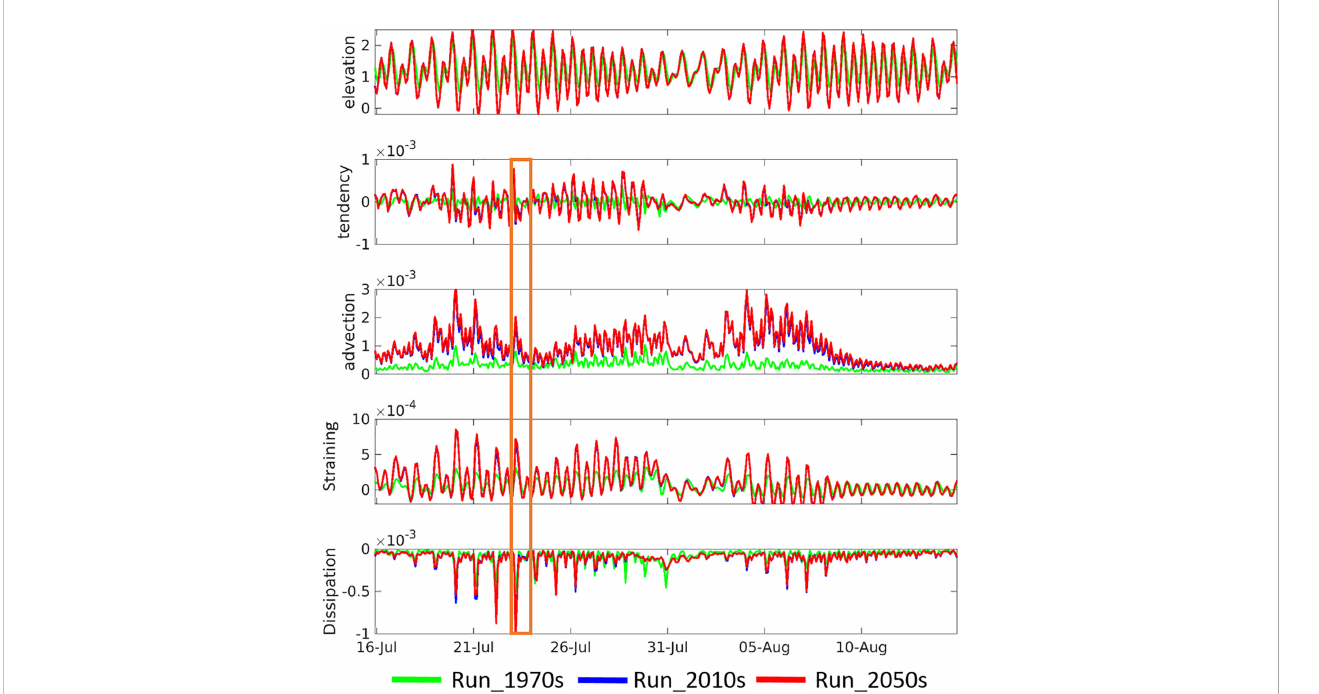
FIGURE 6 Spring-neap tidal cycle re fl ected in the change of water level and corresponding change in the vertical salinity variance (tendency, advection, straining, dissipation) in the Lingding bay (Zone 1). Duration of the typhoon Roke is marked by the orange